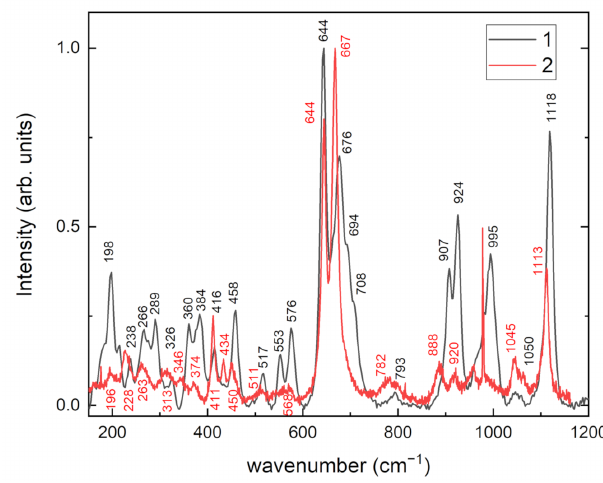
Figure 4. Raman spectra of tinaksite ( 1 ) and tokkoite ( 2